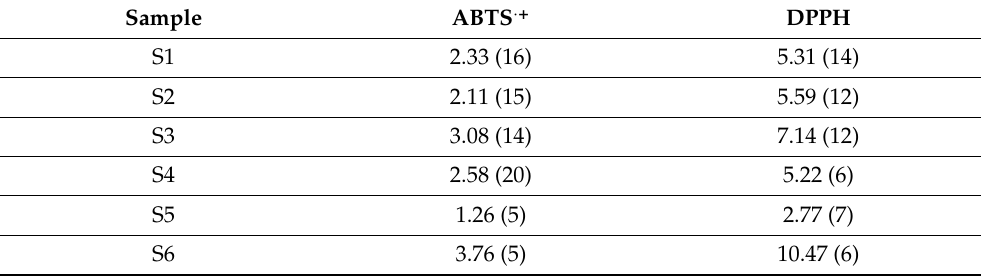
Table 6. Results (IC50; mg DE/mL MeOH) obtained in ABTS · + and DPPH assays. RSD (%) values in